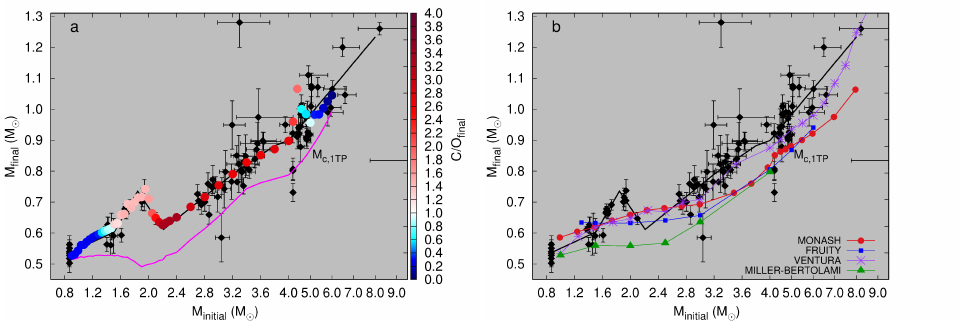
Figure 3. Comparison between theoretical and observed IFMR [3,34]. The black solid line is a fit to the data. ( a ) Results of this work, obtained with the calibrated λ values, color-coded as a function of the final C/O (right color bar). The core mass at the first TP is also shown (magenta line). ( b ): Predictions from various authors, namely: ([30], Ventura, purple stars); ([31,32], Monash, red circles); ([10], FRUITY, blue squares); ([35], Miller–Bertolami, green